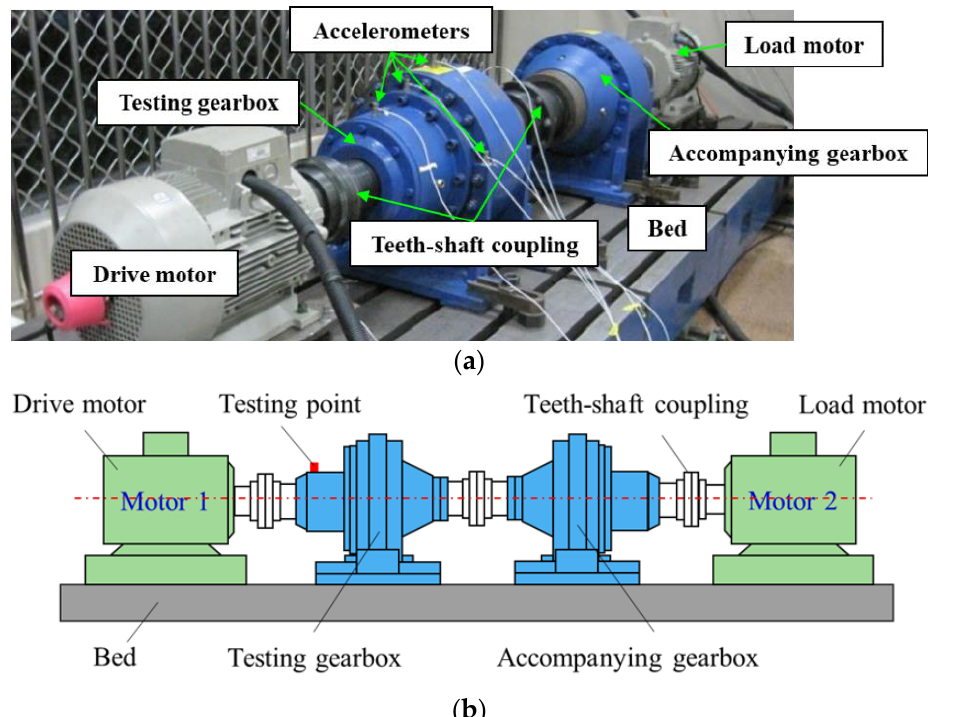
Figure 9. The planetary gearbox photo and diagram: ( a ) experimental setup [45]; ( b ) position schematic for data acquisition. Table 1. Parameters of the spur PGS for simulation and